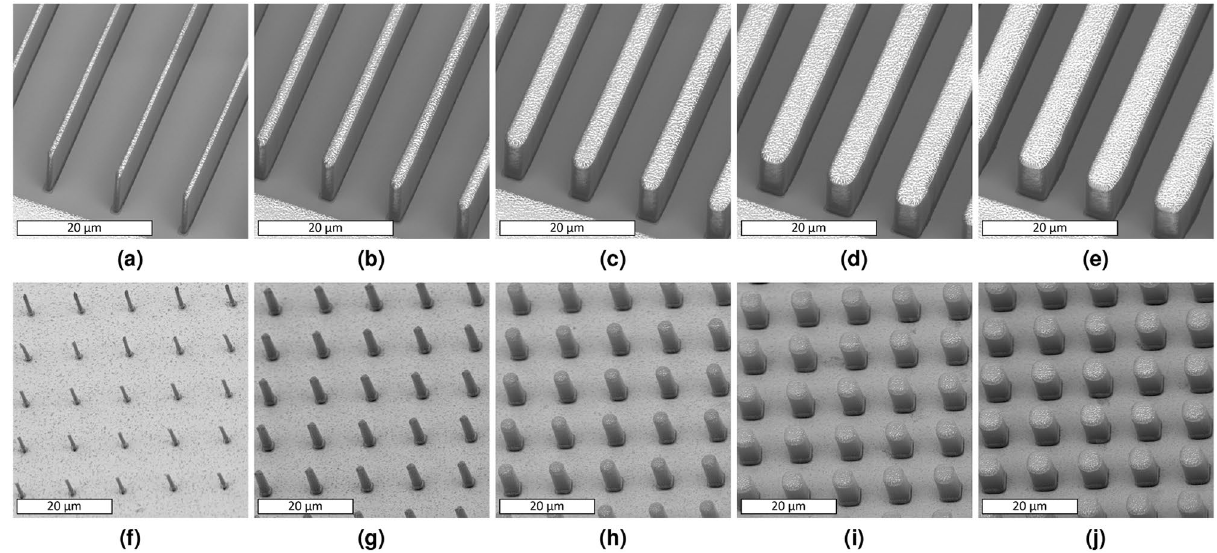
Figure 3. SEM images of pattern transfer of various feature sizes through the self-aligned backside UV lithography. Periodic SU-8 lines with widths of ( a ) 1 µ m , ( b ) 2 µ m , ( c ) 3 µ m , ( d ) 4 µ m , ( e ) 5 µ m ; and periodic SU-8 micropillars with diameters of ( f ) 1 µ m , ( g ) 2 µ m , ( h ) 3 µ m , ( i ) 4 µ m , ( j ) 5 µ m